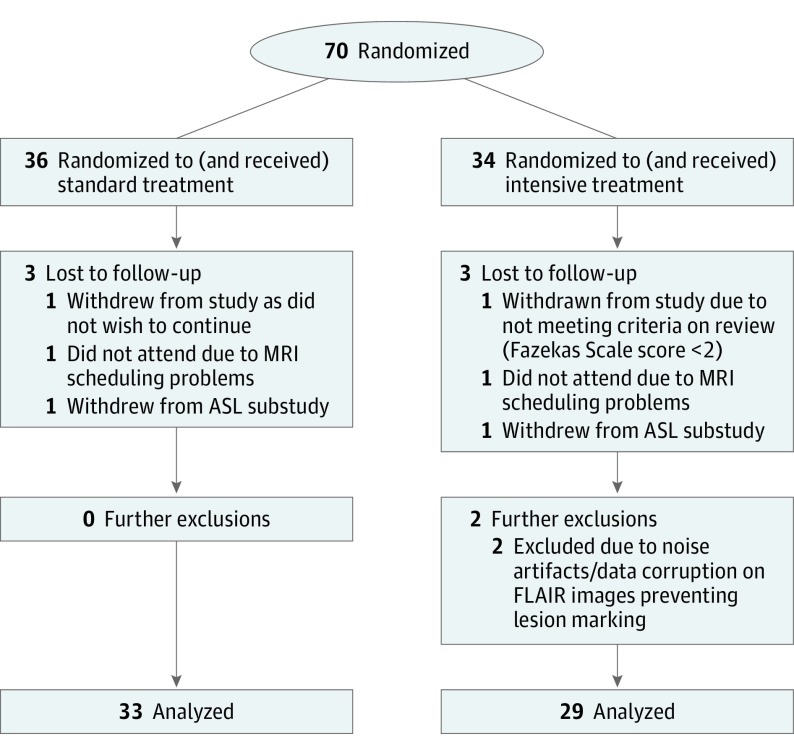
CONSORT DiagramShown is an overview of the participant flow, sample sizes, and dropout characterization for this analysis. ASL indicates arterial spin labeling; CONSORT, Consolidated Standards of Reporting Trials; FLAIR, fluid-attenuated inversion recovery; and MRI, magnetic resonance imaging.